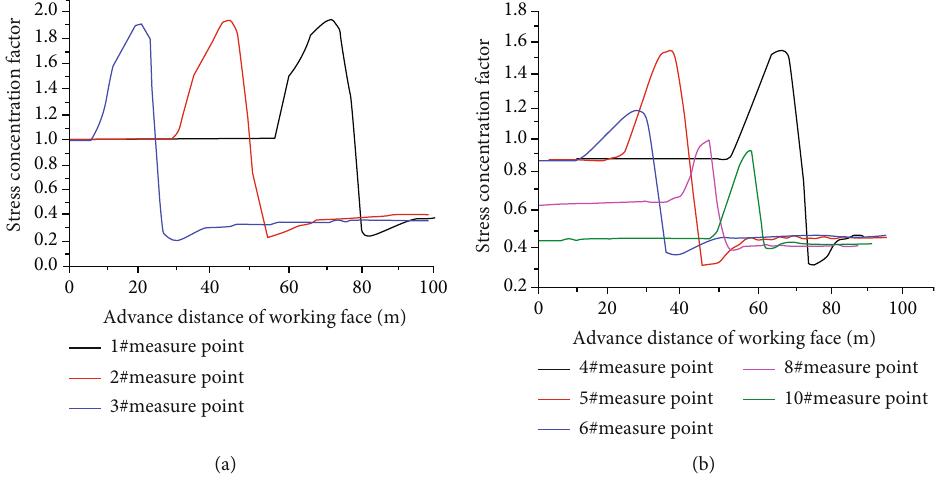
Figure 12: Stress concentration coe ffi cients at mining points in the J coal